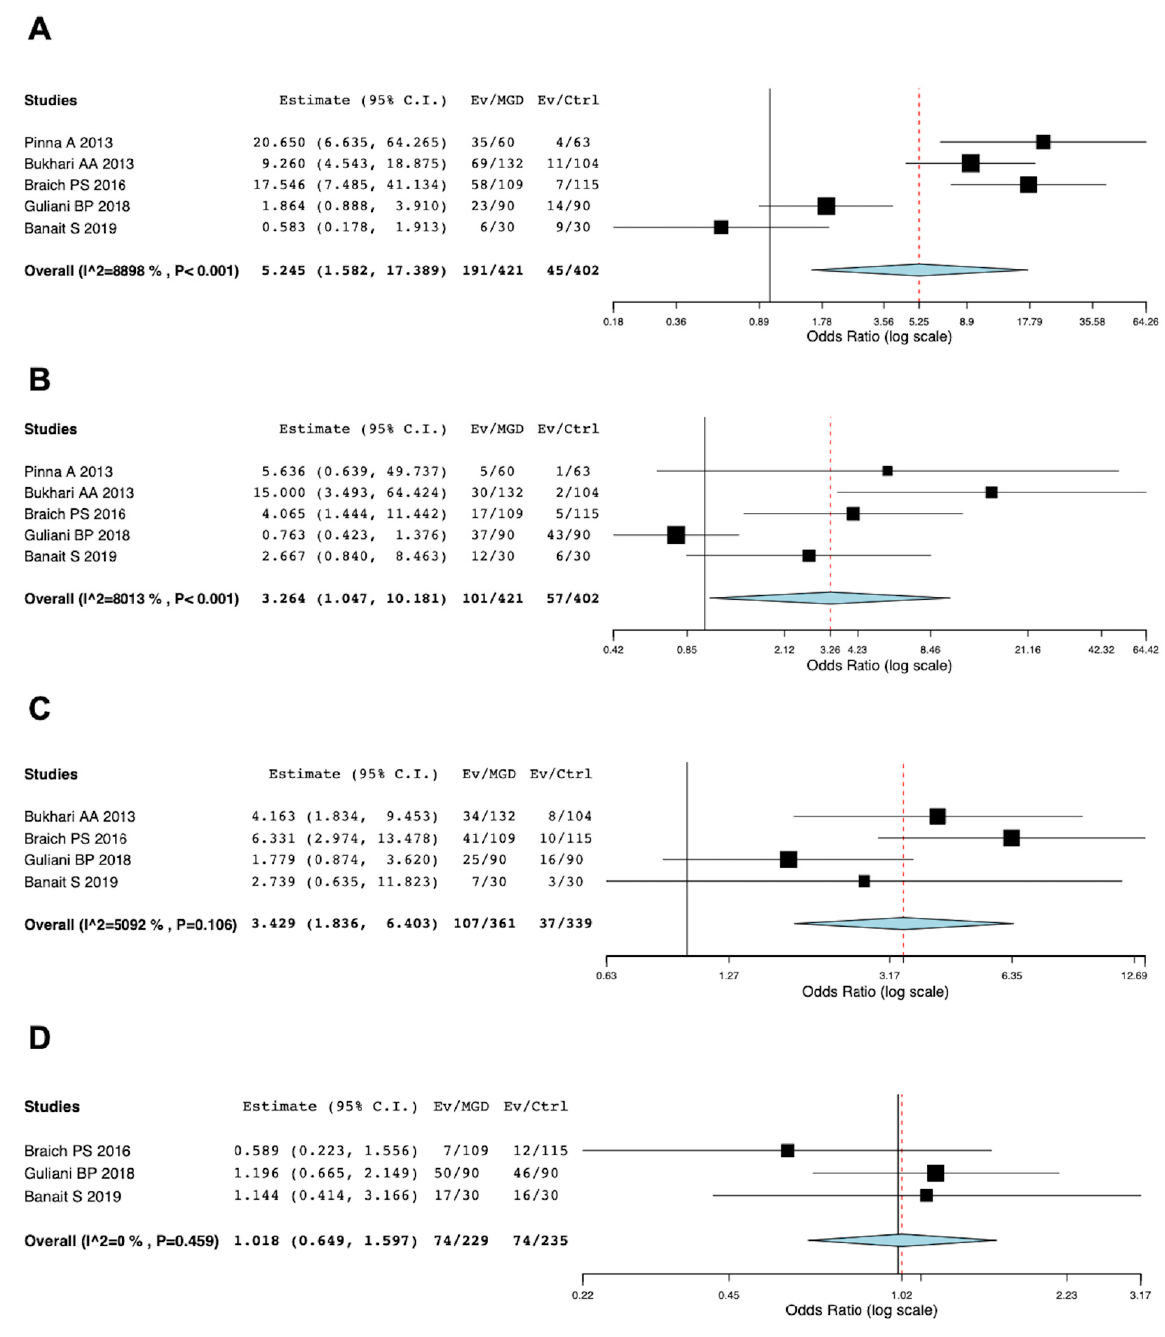
Figure 2. Meta-analysis for the presence of dyslipidemia in MGD patients. ( A ). Total cholesterol (TC) ≥ 200 mg/dL, ( B ). Triglyceride (TG) ≥ 150 mg/dL, ( C ). Low-density lipoprotein (LDL) ≥ 150 mg/dL, ( D ). High-density lipoprotein (HDL) ≤ 40 mg/dL.